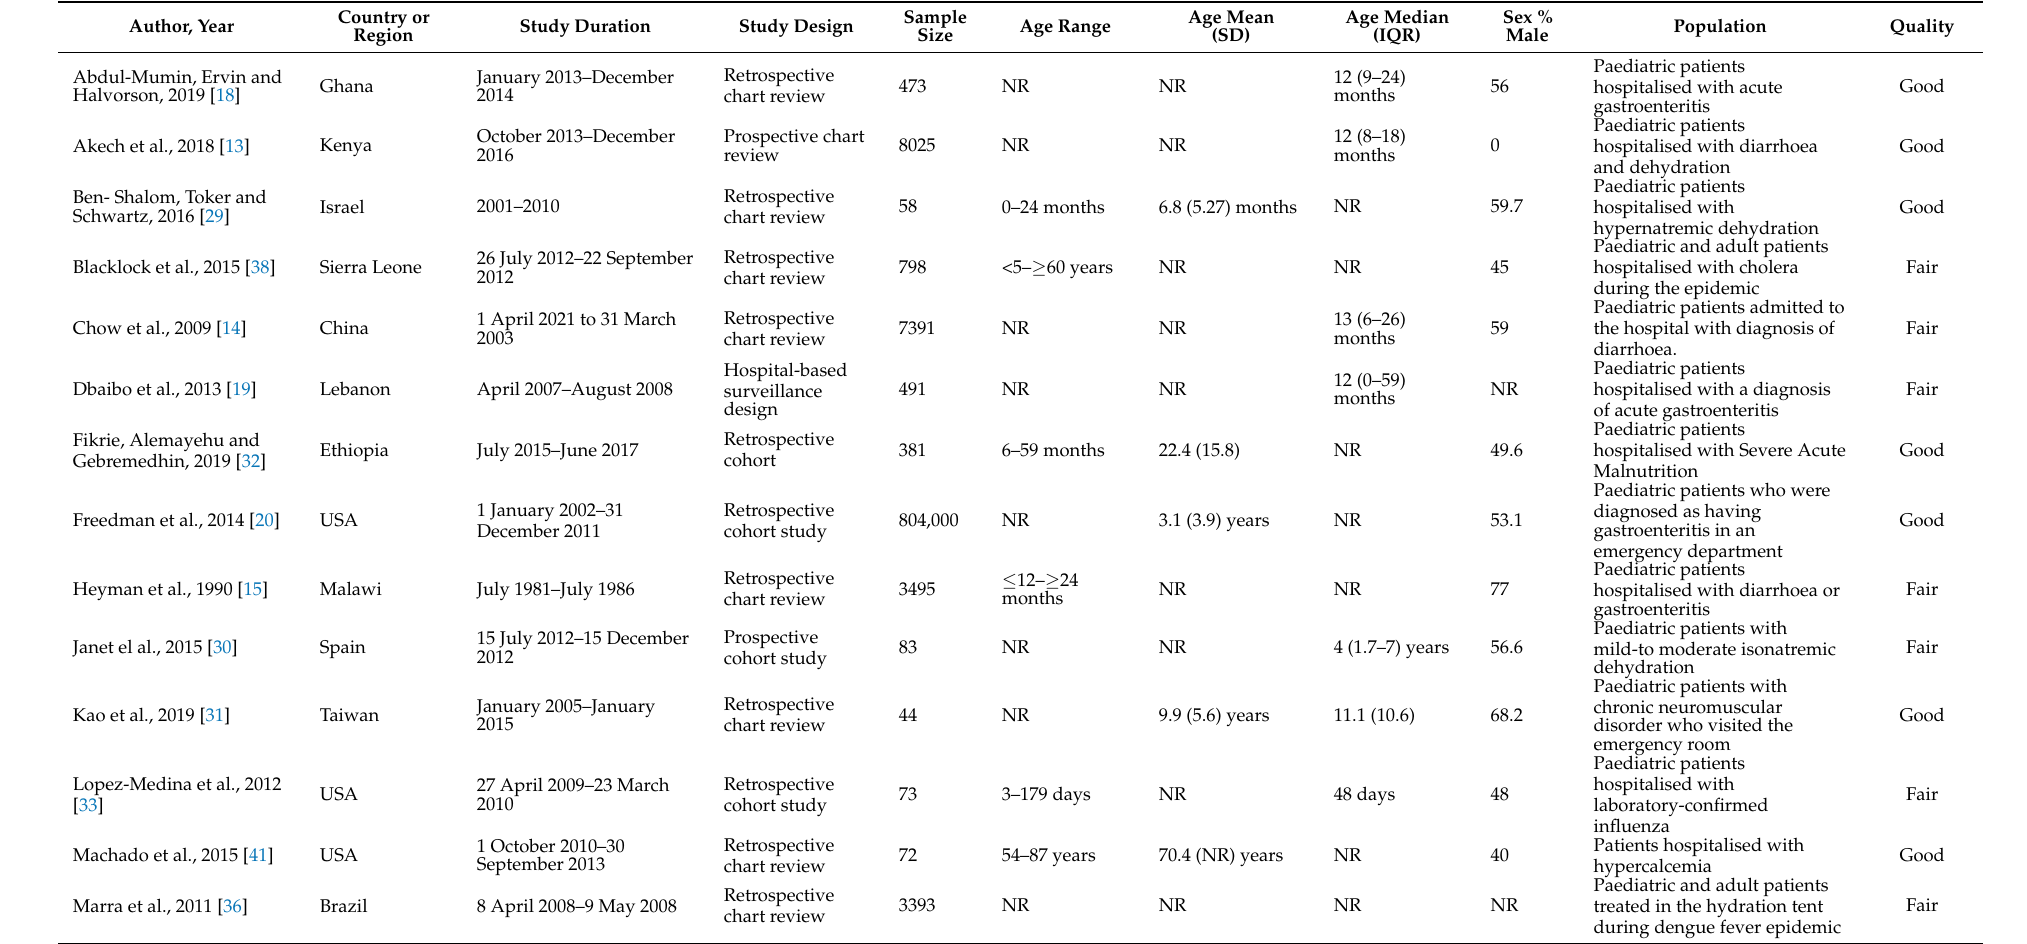
Table 1. Demographic characteristics of included